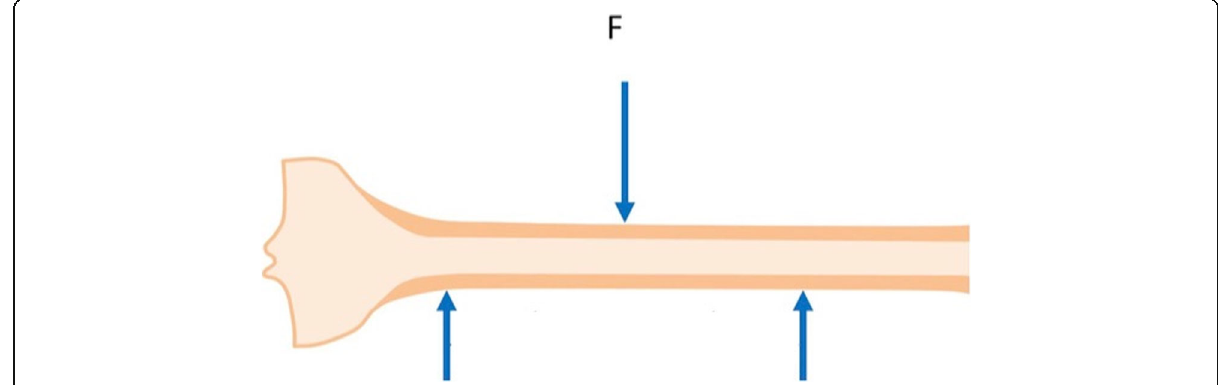
Fig. 2 Schematic representation of the 3-point bending test protocol. F